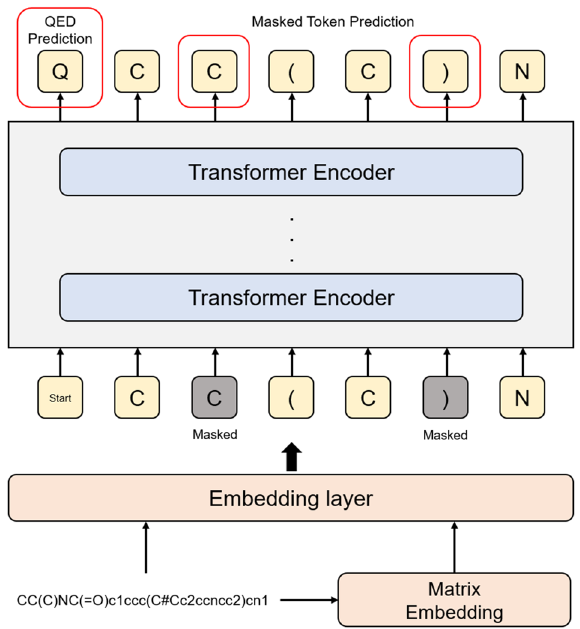
Figure 1. The overview of our pre-training methods and model. The input SMILES is converted to input vectors via embedding layer. The red boxes are targets of pre-training among the outputs of Transformer. The fine-tuning uses the same architectures except output